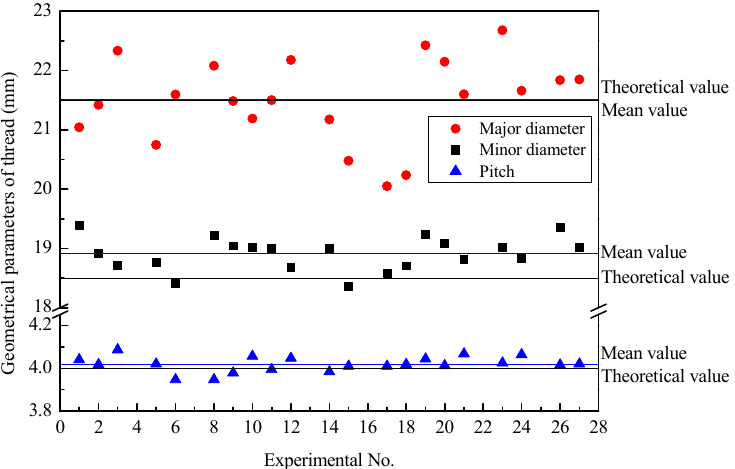
Figure 11. Basis parameters of the threaded section after synchronous rolling.